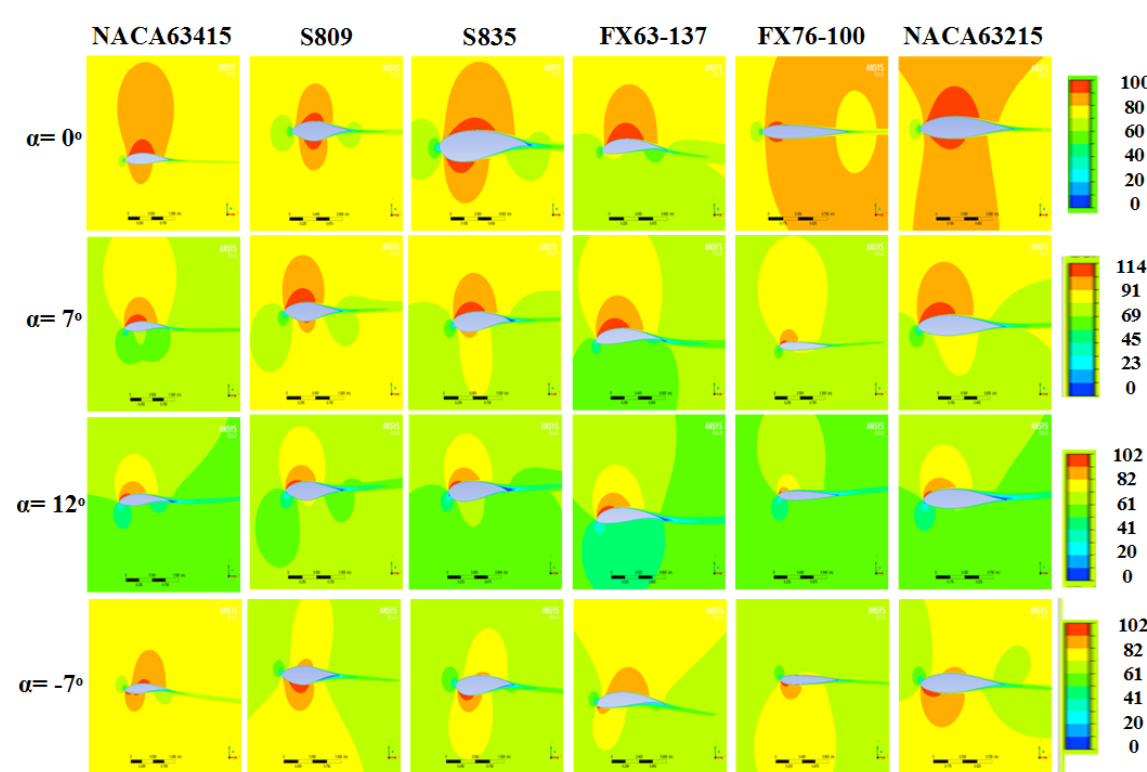
Figure 7. Velocity contour around airfoils.